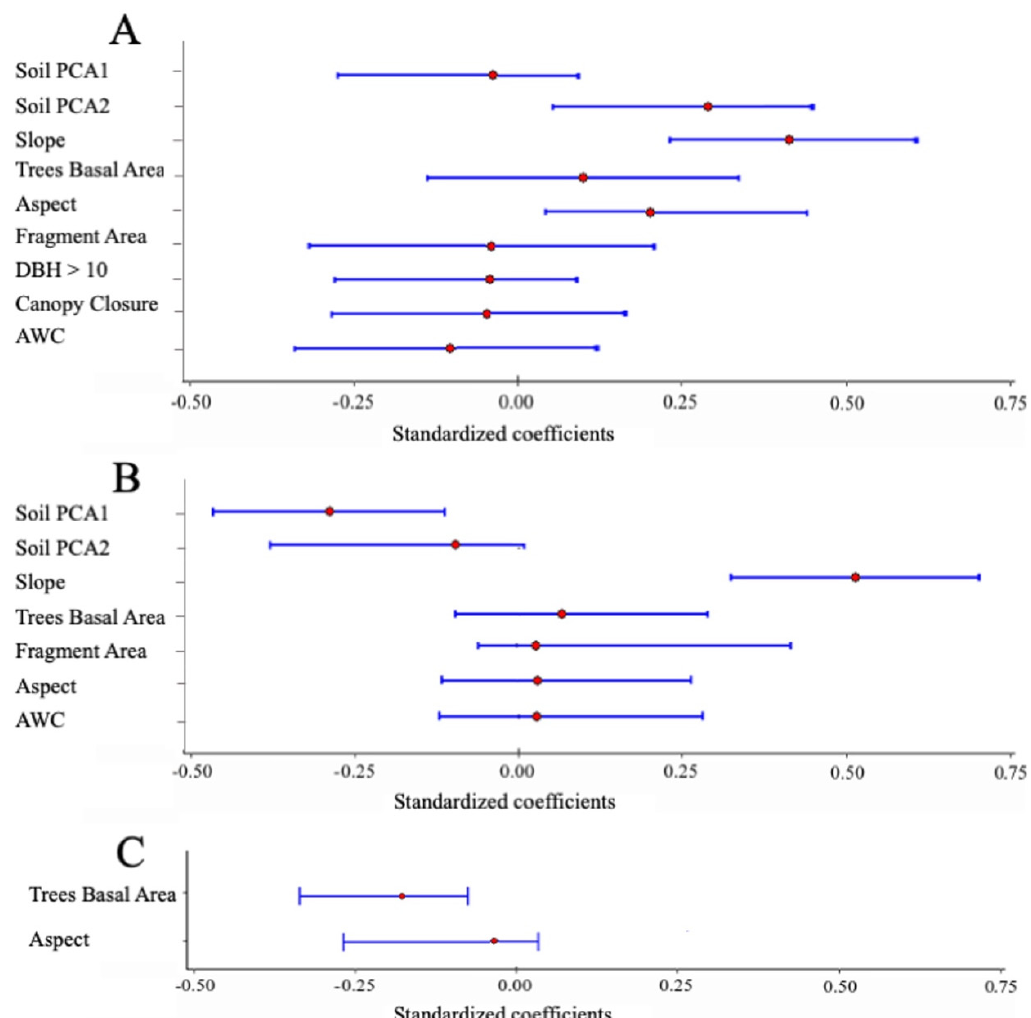
Figure 2. GLMM results showing the effect of forest structure, soil properties, topography, and forest fragment size on ( A ) fern abundance, ( B ) fern species richness, and ( C ) fern composition (full results given in Table A2 Appendix A). Red circles represent the coefficient estimates, blue lines represent the 95% confidence intervals. Figure showing only the variables that were selected during the model averaging process.